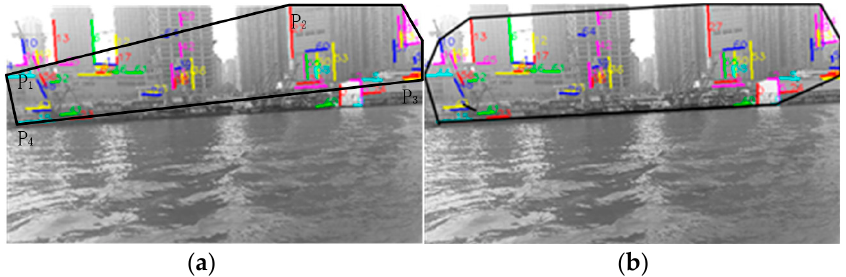
Figure 9. The shore area is generated by the single image; ( a ) effective selection of initial values to generate polygon area, ( b ) acquisition of the shore area.